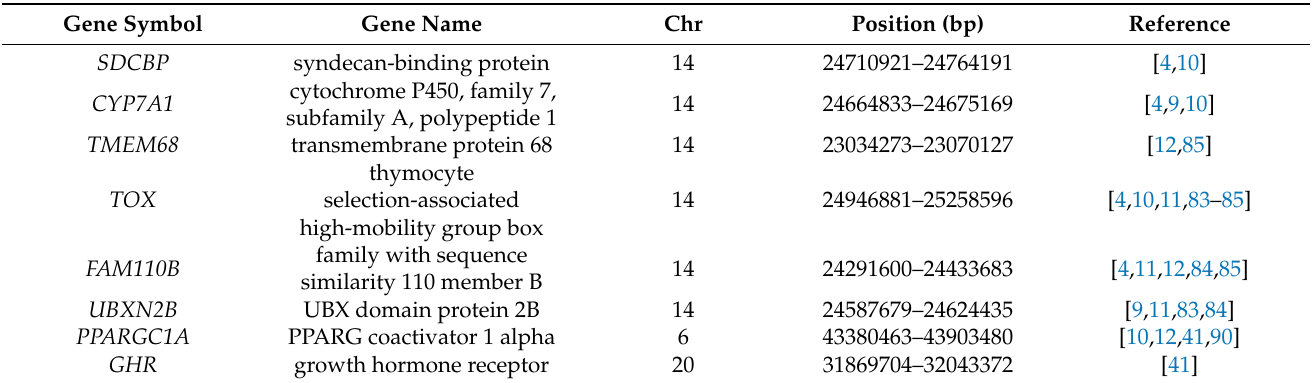
Table 2. Description and chromosomal location of the most important genes related to carcass weight in Hanwoo